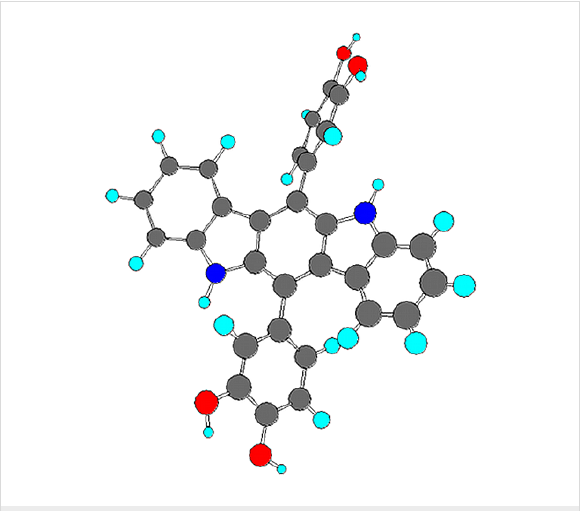
Figure 2: The AM1 optimized structure of receptor 1 (heat of forma- tion = −8.29